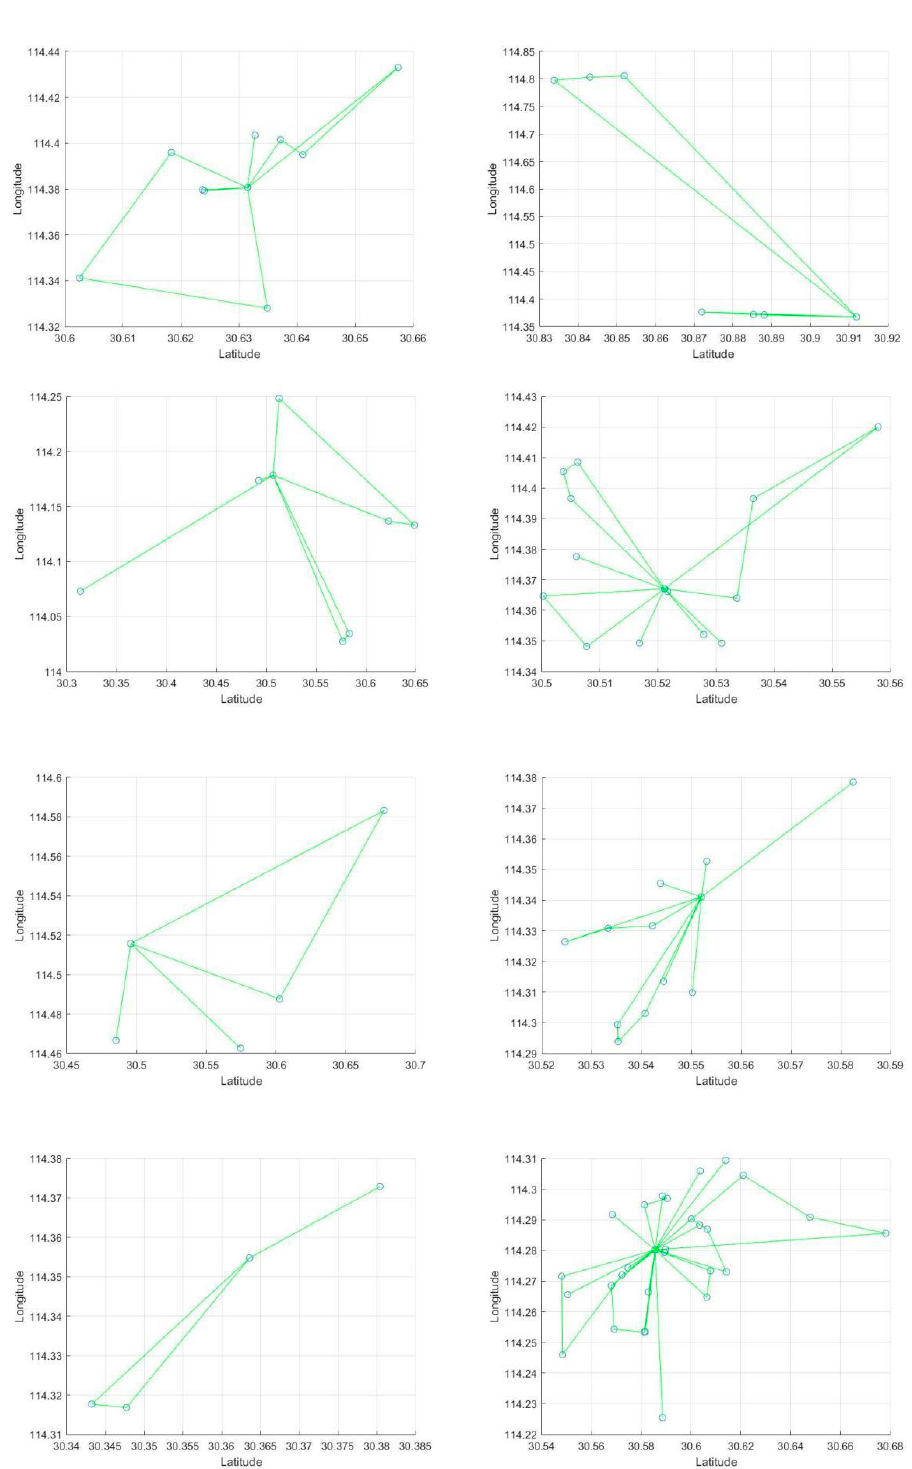
Figure 7. Vehicle allocation and paths for each transport